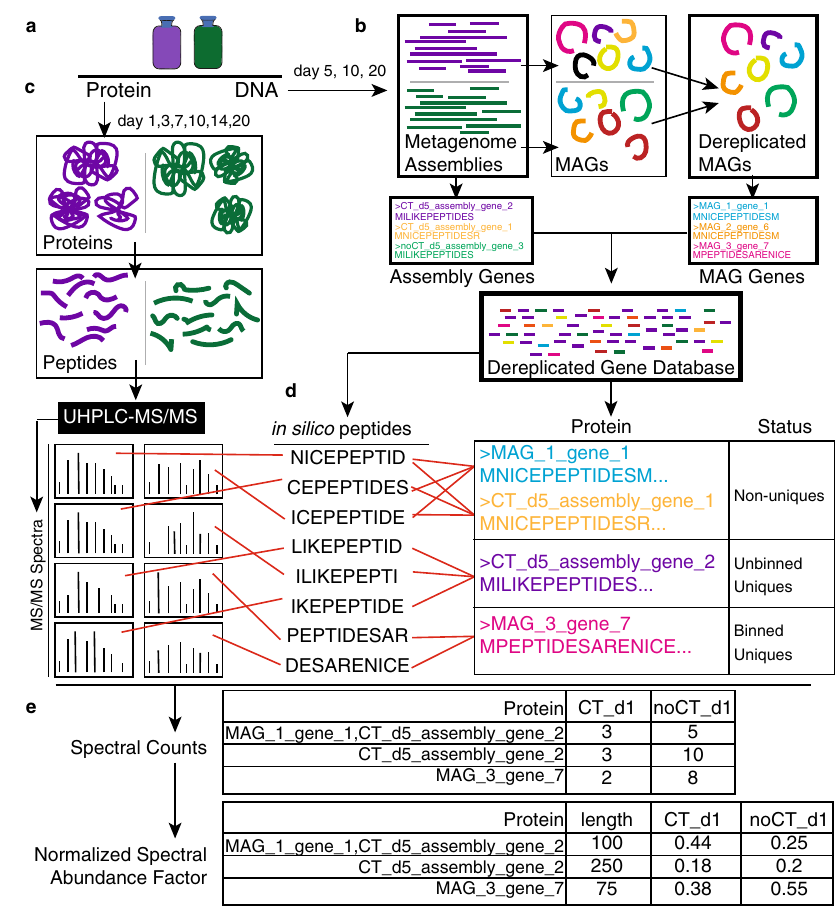
Fig. 4 Work fl ow for genome-resolved metaproteomics. a DNA and proteins were sampled from triplicate live soil + CT (purple) and unamended soil (green) reactors at days 5, 10, 20 (DNA) and days 1, 3, 7, 10, 14, 20 (protein). b Metagenomes at each timepoint were obtained for both CT (purple) and unamended (green) treatments. Metagenomes were assembled and binned to obtain metagenome-assembled genomes (MAGs) across all samples. This set of MAGs was dereplicated at 99% ANI to obtain a MAG database of 155 dereplicated MAGs (Fig. 3). Using amino acid translations of genes derived from this dereplicated MAG database and remaining genes from metagenomic assemblies (on unbinned scaffolds >2500 bp), we compiled a Dereplicated Gene Database (all unique gene sequences) that served as our reference database for our metaproteomes. c Metaproteomes at each timepoint were obtained as described in Methods. d Spectral matching was carried out using obtained spectra and in silico spectra derived from the gene database. From this, proteins were classi fi ed as “ non-unique ” if the recruited peptides could be derived from other proteins in the database. Proteins were classi fi ed as “ unbinned uniques ” if they had peptides that could only be matched to the amino acid sequence derived from a metagenomic unbinned scaffold in our assembly. Proteins were identi fi ed as “ binned uniques ” if they had peptides that could only be matched to that amino acid sequence, and were derived from a single genome in our MAG database. e All identi fi ed proteins were quanti fi ed with label-free spectral counts. This was then corrected for protein length and sample-to-sample variation by conversion to normalized spectral abundance